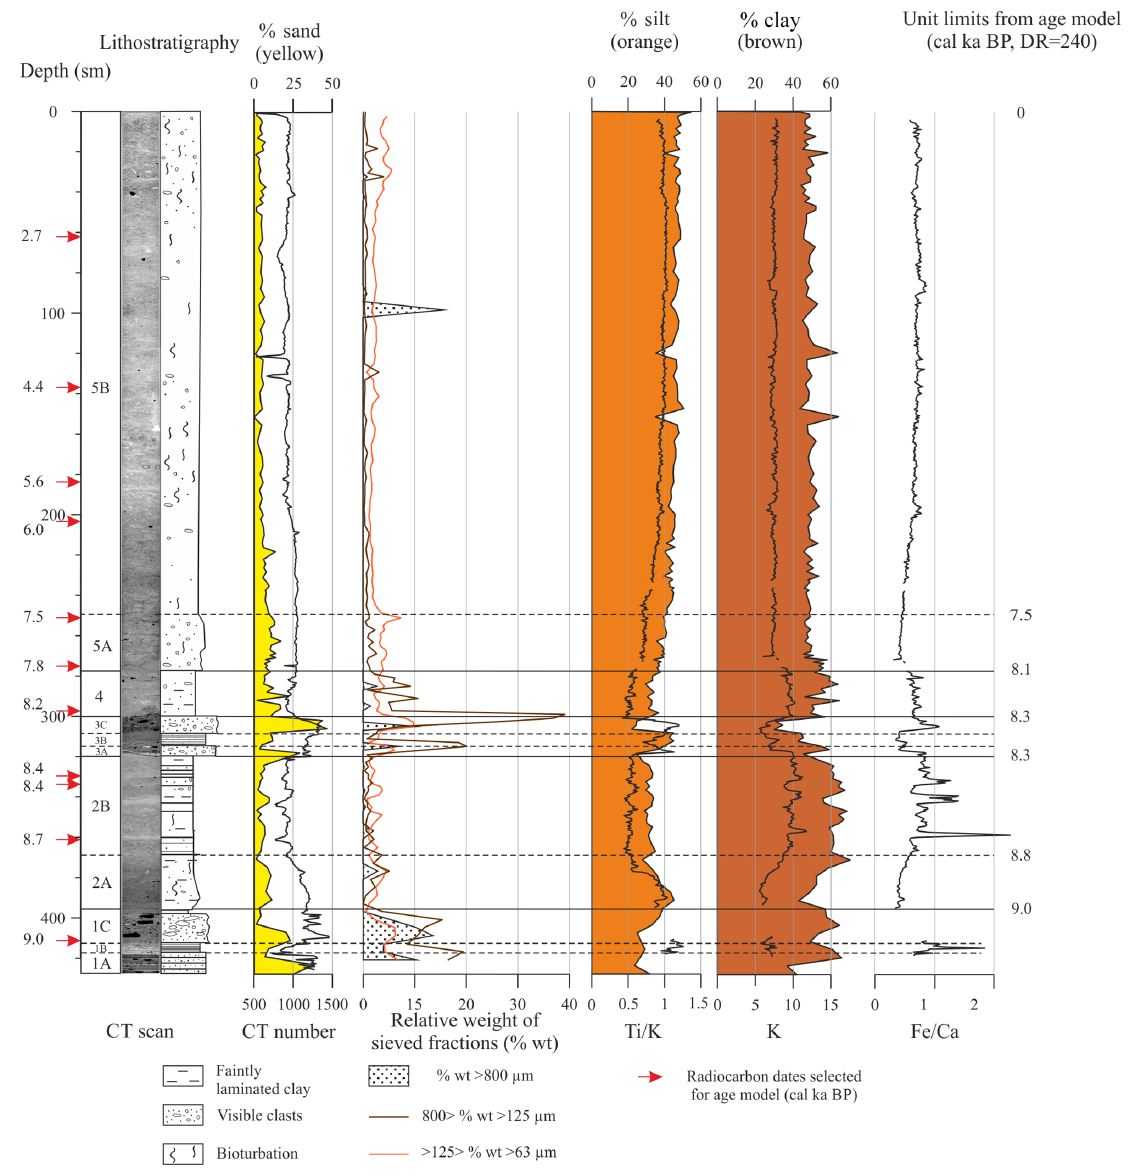
Figure 6. Sedimentological results and elemental signature of the detrital fraction of core AMD14-Kane2b. Laser diffraction grain size repartition (<2mm fraction) is shown as % sand, silt, and clay. Normalised Zr counts are not shown but their profile is similar to that of